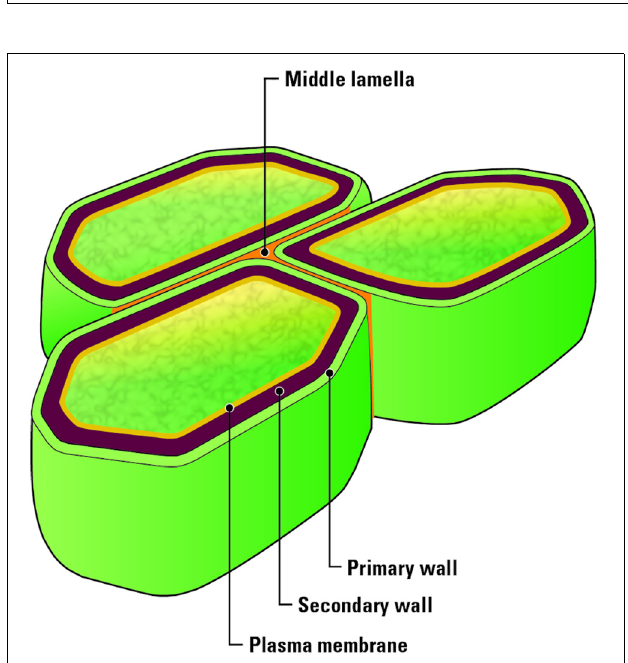
S3 layers, which contributes to the strength of the plant tissues (Zhong and Ye, 2014).